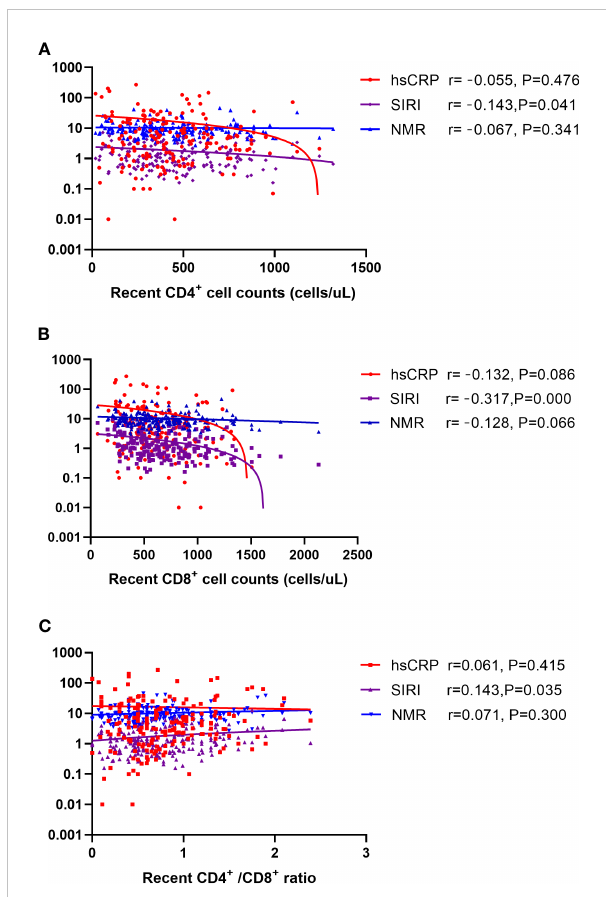
FIGURE 3 Scatter plot of the correlation between hsCRP, SIRI, and NMR with (A) recent CD4 + cell counts (B) recent CD8 + cell counts (C) CD4 + / CD8 + ratio. Note: The ordinate is log transformed. Abbreviations: hsCRP, high-sensitivity C-reactive protein; SIRI, systemic in fl ammation response index; NMR, neutrophil-to-monocyte